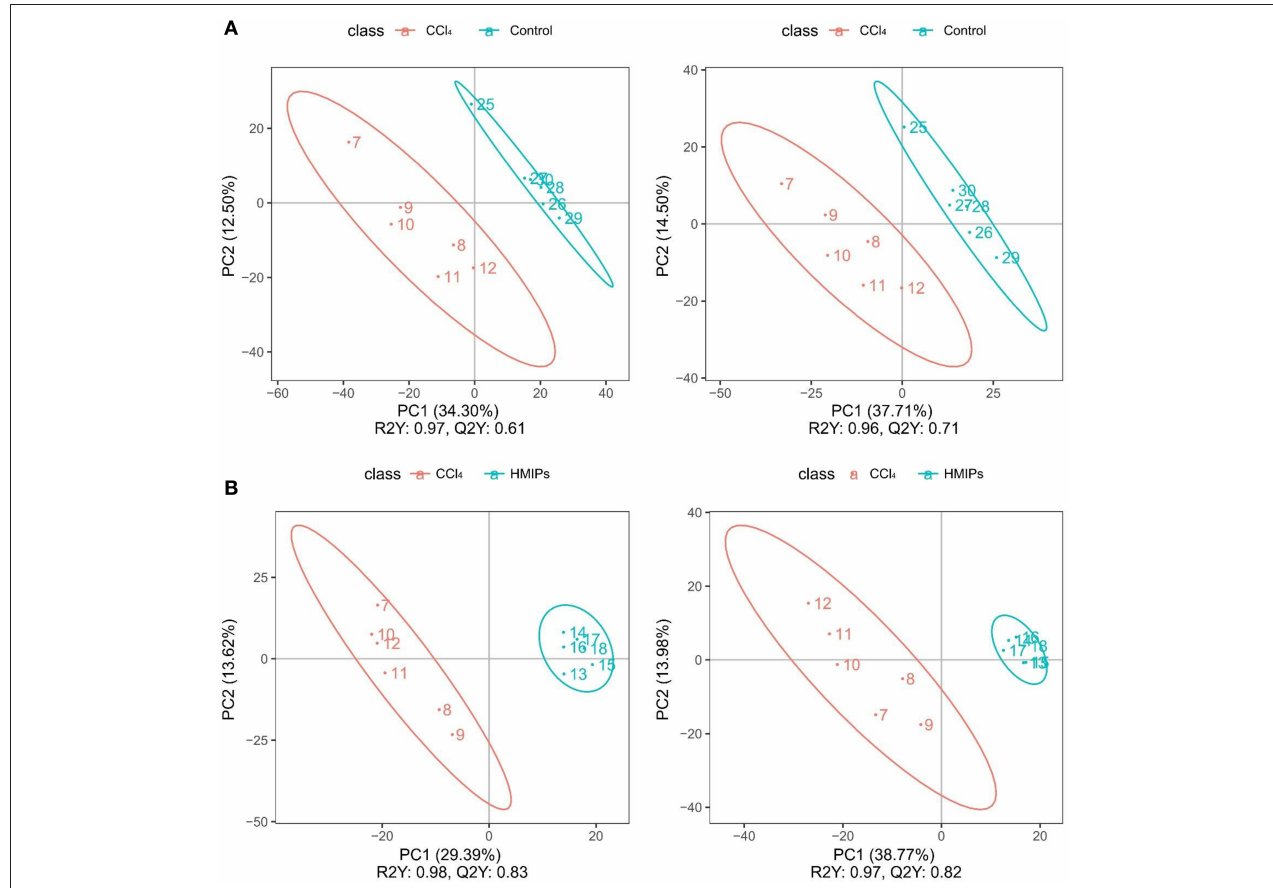
FIGURE 8 | Partial least squares-discriminant analysis (PLS-DA) score plots of the serum samples. (A) PLS-DA score plots of the control and CCl 4 groups under the positive and negative ion models. (B) PLS-DA score plots of the HMIP and CCl 4 groups under the positive and negative ion models.